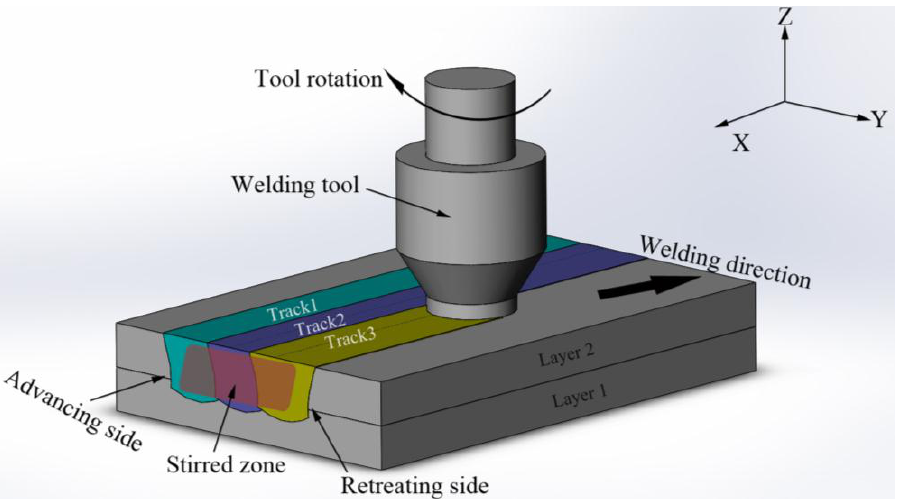
Figure 1. Schematic of the multi-track friction stir lap welding (FSLW) process.